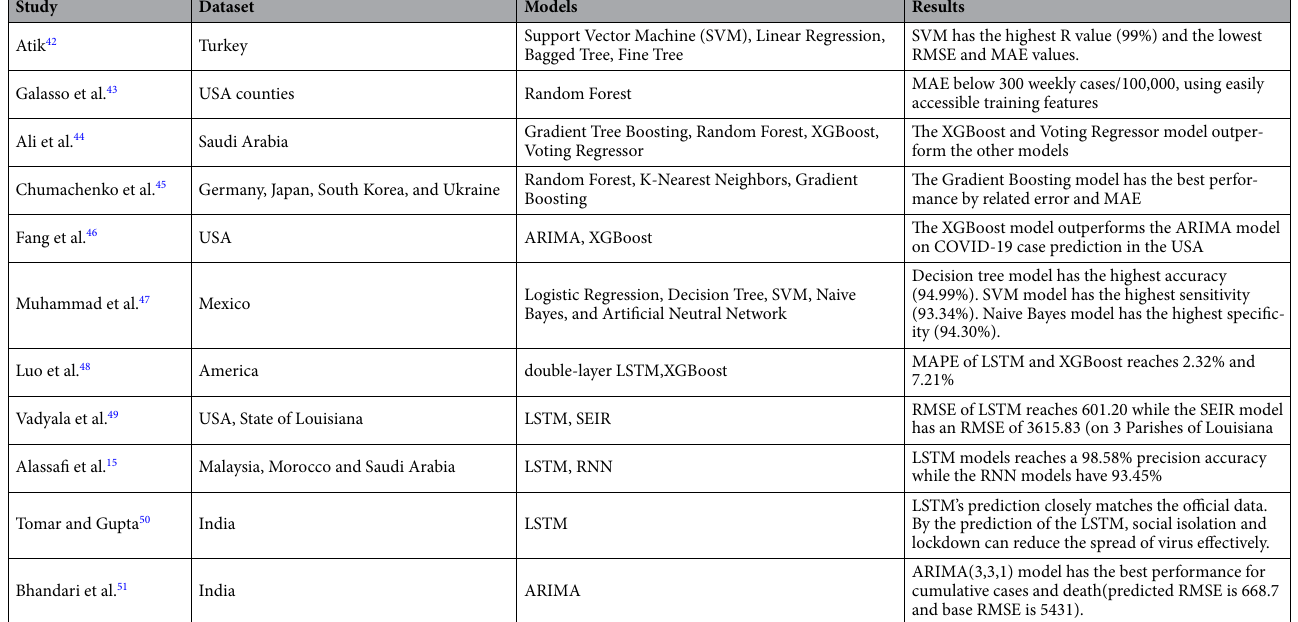
Table 1. A non-exhaustive list of previous works on data-driven models for COVID-19 cases prediction in the past three years. Most commonly used evaluation metrics are RMSE, MAE, and